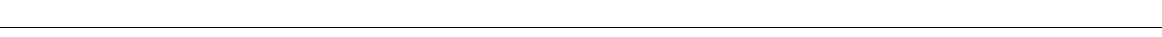
Fig. 2 NBs are liquid organelles. a NBs are close to spherical. Distribution of axial ratios of NBs observed 12 h p.i. (20 cells and 100 NBs). The axial ratio ( a / b ) was determined by fi tting the NB to an ellipse having the same second moments of area using the image toolbox of MatLab software ( a , b : long and short axes of the ellipse). b NBs can fuse together. BSR cells infected by rCVSN2C-P-mCherry were imaged at the indicated time ( lower left corner ). The initial time corresponds to 15 h p.i ( top row ) and 18 h p.i. ( bottom row ). Images have been extracted from Supplementary Movies 1 and 2 and are shown at 10-sec intervals ( top row ) and 5-sec intervals ( bottom row ). Scale bars: 3 µ m. c Spherical bubbles cross NBs. BSR cells infected by rCVSN2C-P-mCherry were imaged at the time indicated ( lower left corner ). The initial time corresponds to 16 h p.i. Images have been extracted from Supplementary Movie 3 and are shown at 5-s intervals. Scale bar: 3 µ m. d NBs are sensitive to a hypotonic shock. BSR cells infected by rCVSN2C-P-mCherry were imaged. A hypotonic shock was applied at indicated t = 0 (corresponding to 18 h p.i.). Images are shown at 2-min intervals. Images have been extracted from Supplementary Movie 4. Scale bar: 15 µ m. e – h Fluorescence recovery after photobleaching (FRAP) of P-mCherry in BSR cells at 37 °C. The diameter of